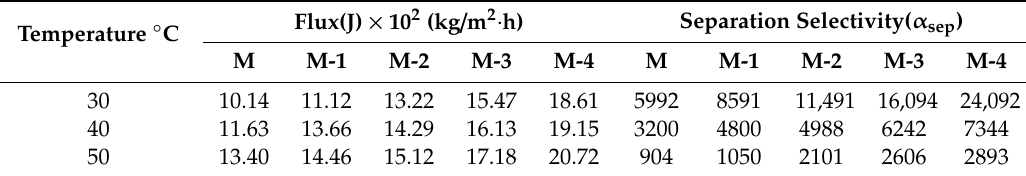
Table 4. Pervaporation flux and separation selectivity of di ff erent membranes at di ff erent temperatures with 10 % water in the